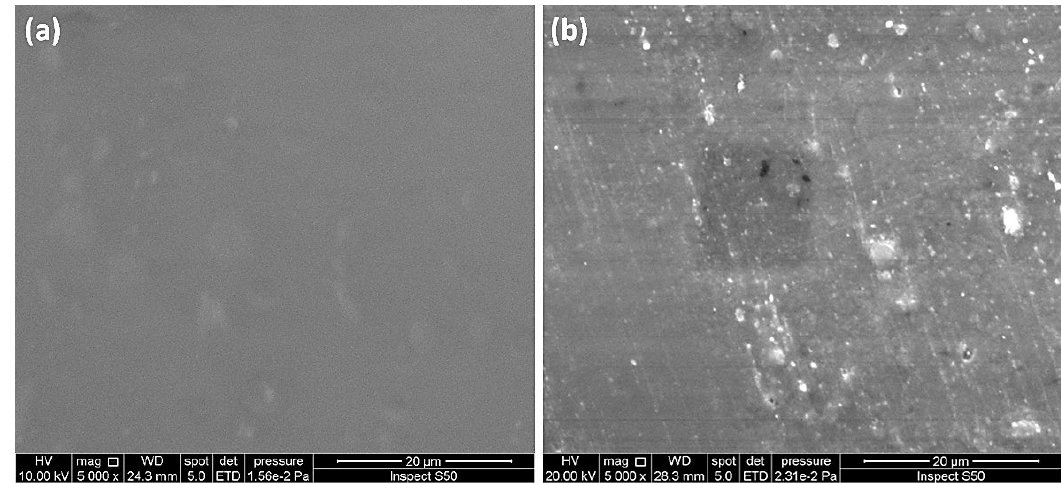
Figure 8. SEM images of the blank PVC film: ( a ) before irradiation and ( b ) after irradiation. Molecules 2021 , 26 , x FOR PEER REVIEW